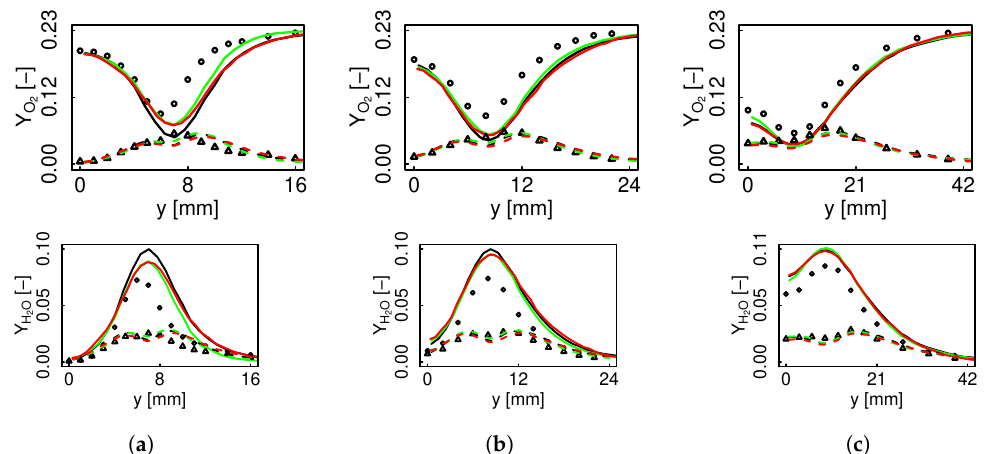
Figure 14. O 2 and H 2 O mean and RMS radial profiles for flame E. Black color represents non- premixed FTACLES, green color premixed FTACLES, red color FPV, solid line mean, dashed line RMS. Circles depict experimental mean, and triangles represent experimental RMS. ( a ) x / d = 7.5; ( b ) x / d = 15; ( c ) x / d = 30.